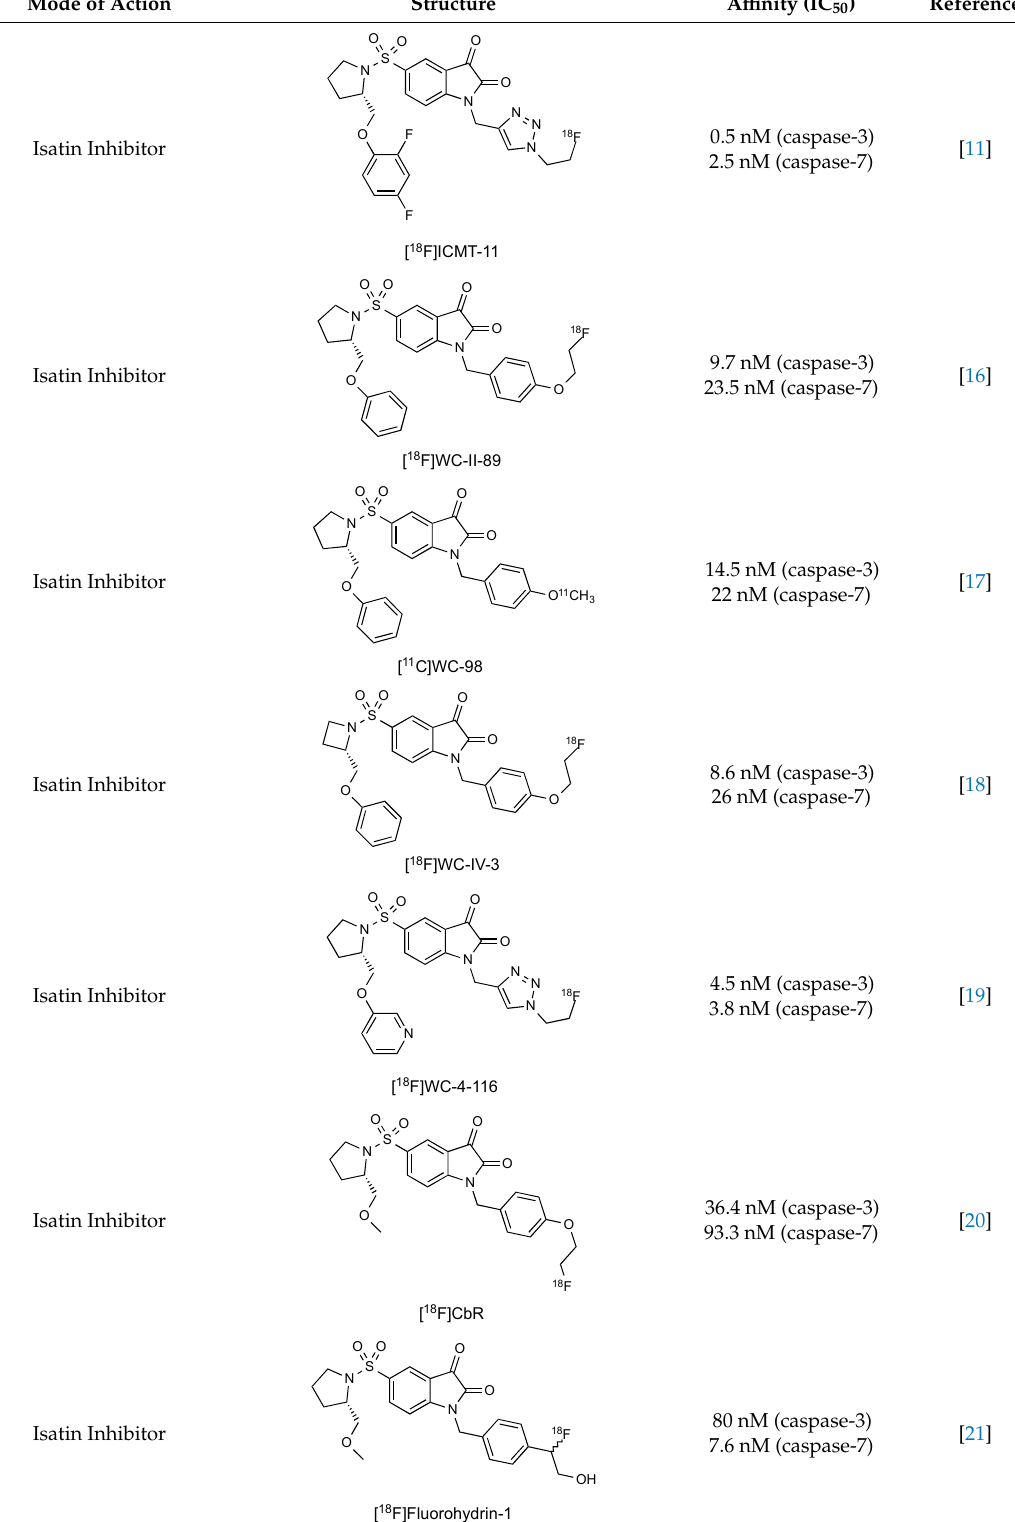
Table 1. List of non ‐ peptidic inhibitors of caspase ‐ 3/7.